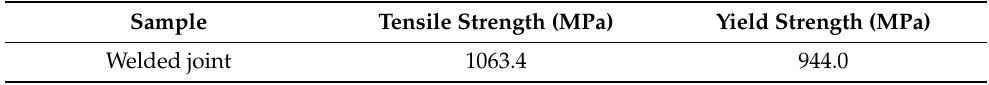
Table 2. Tensile properties of welded joints.